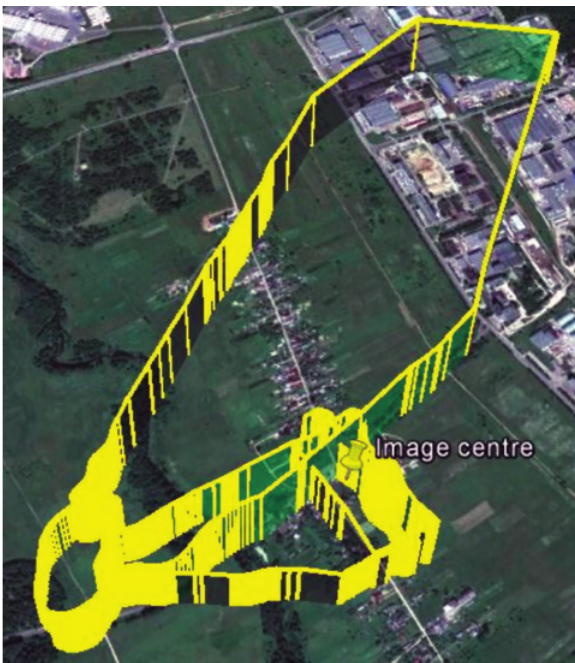
Fig. 4. Autonomous flight plan and area in Google Earth application